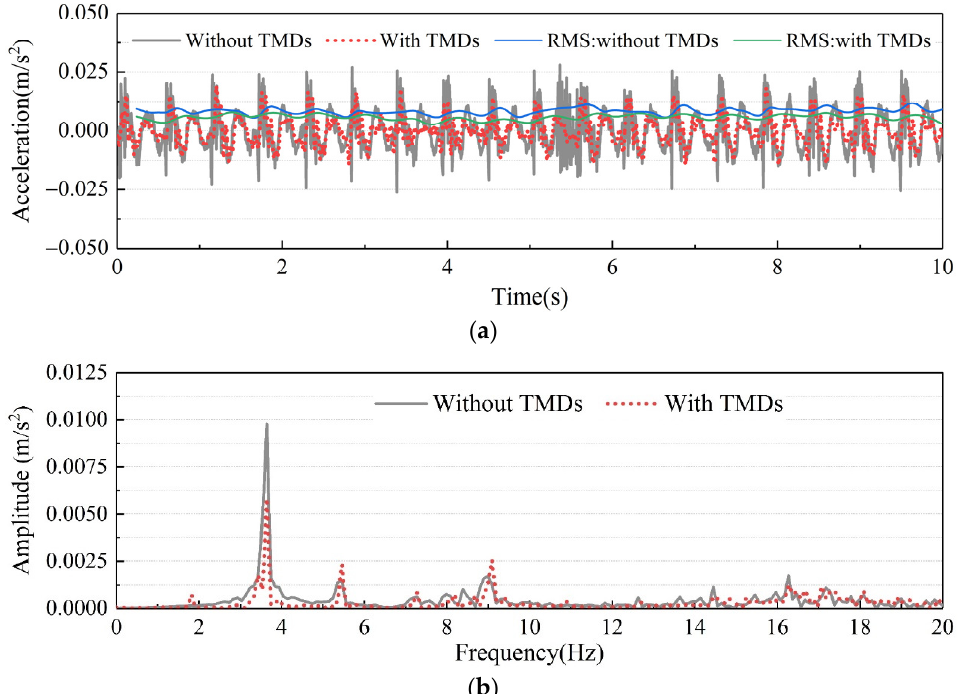
Figure 18. Comparison of the measured acceleration time time-history responses and corresponding FFT spectrum of the suspended floor with and without TMDs under case WP-1: ( a ) acceleration time-history response; ( b ) FFT spectrum.